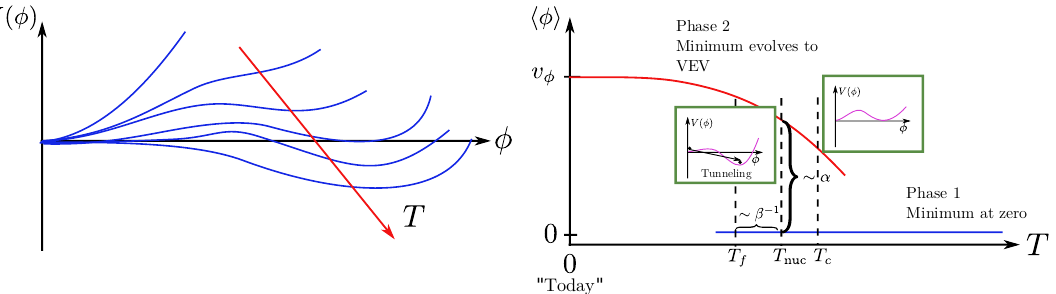
Figure 1: Left: Qualitative temperature dependence of a typical potential in particle physics developing a barrier and new global minimum as temperature drops. Right: Schematic illustration of the temperature dependence of the VEV (order parameter) in a FPT. Shown are also the two important temperatures T and T at which the c nuc minima are degenerated and at which the nucleation probability reaches one bubble per Hubble volume, respectively. The temperature at which the transition is com- pleted is denoted by T f